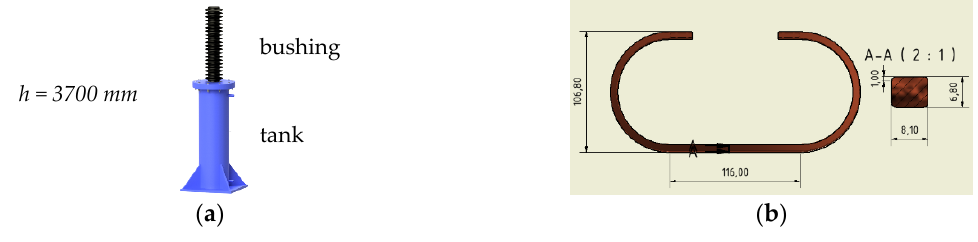
Figure 1. ( a ) Steel test tank ( V = 320 L ) with bushing and ( b ) copper electrode for transformer conductor tests.